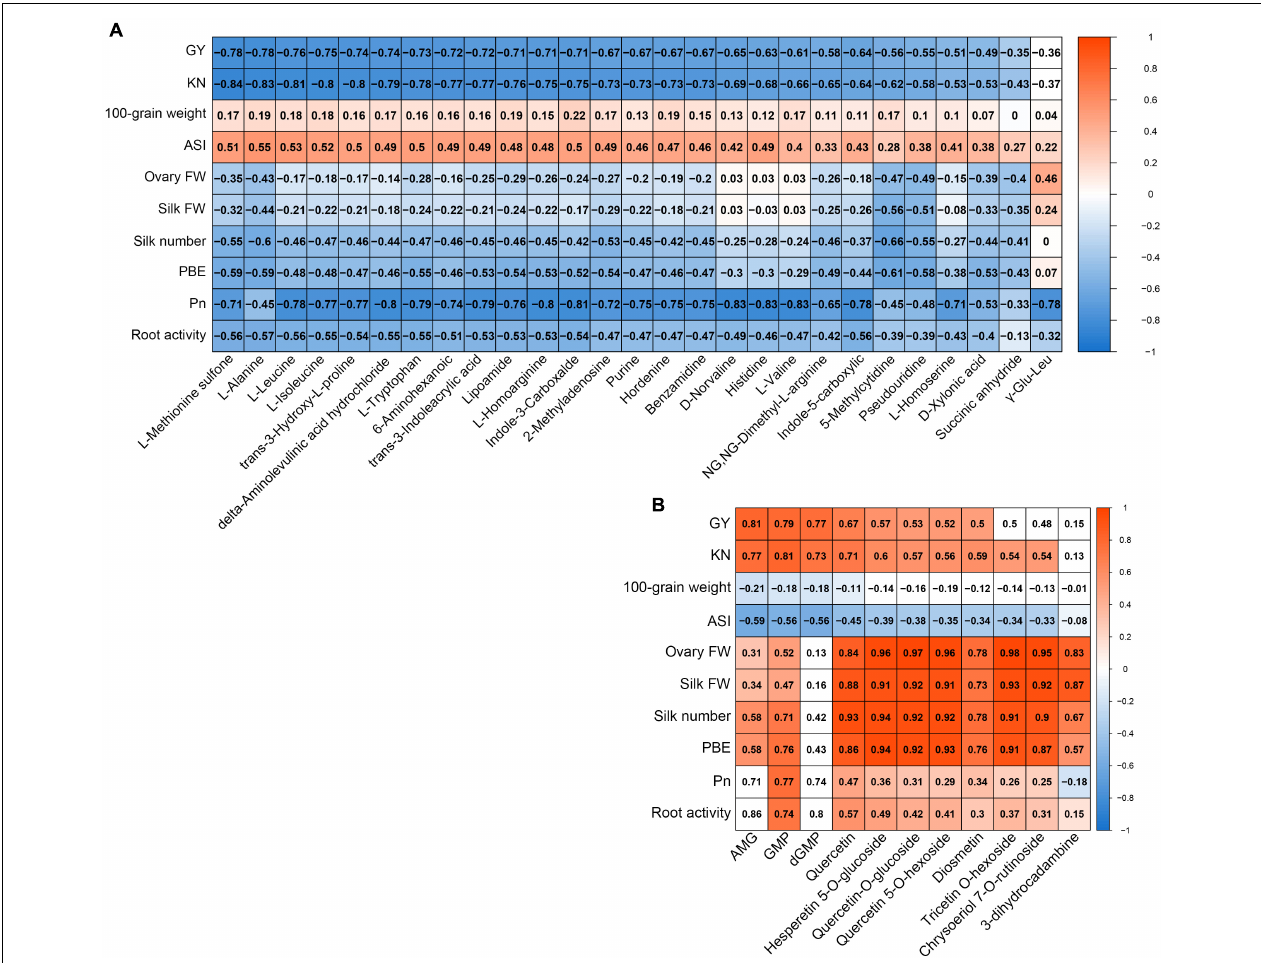
FIGURE 7 | Correlation coefficient matrix of metabolites from yellow module whose accumulation patterns in ovary correlate with agronomic and source strength traits (A) . Correlation coefficient matrix of metabolites from red module whose accumulation patterns in silk correlate with agronomic and source strength traits (B) . Blue fill color, significant negative correlation; red fill color, significant positive correlation ( P < 0.05); white fill color, P ≥